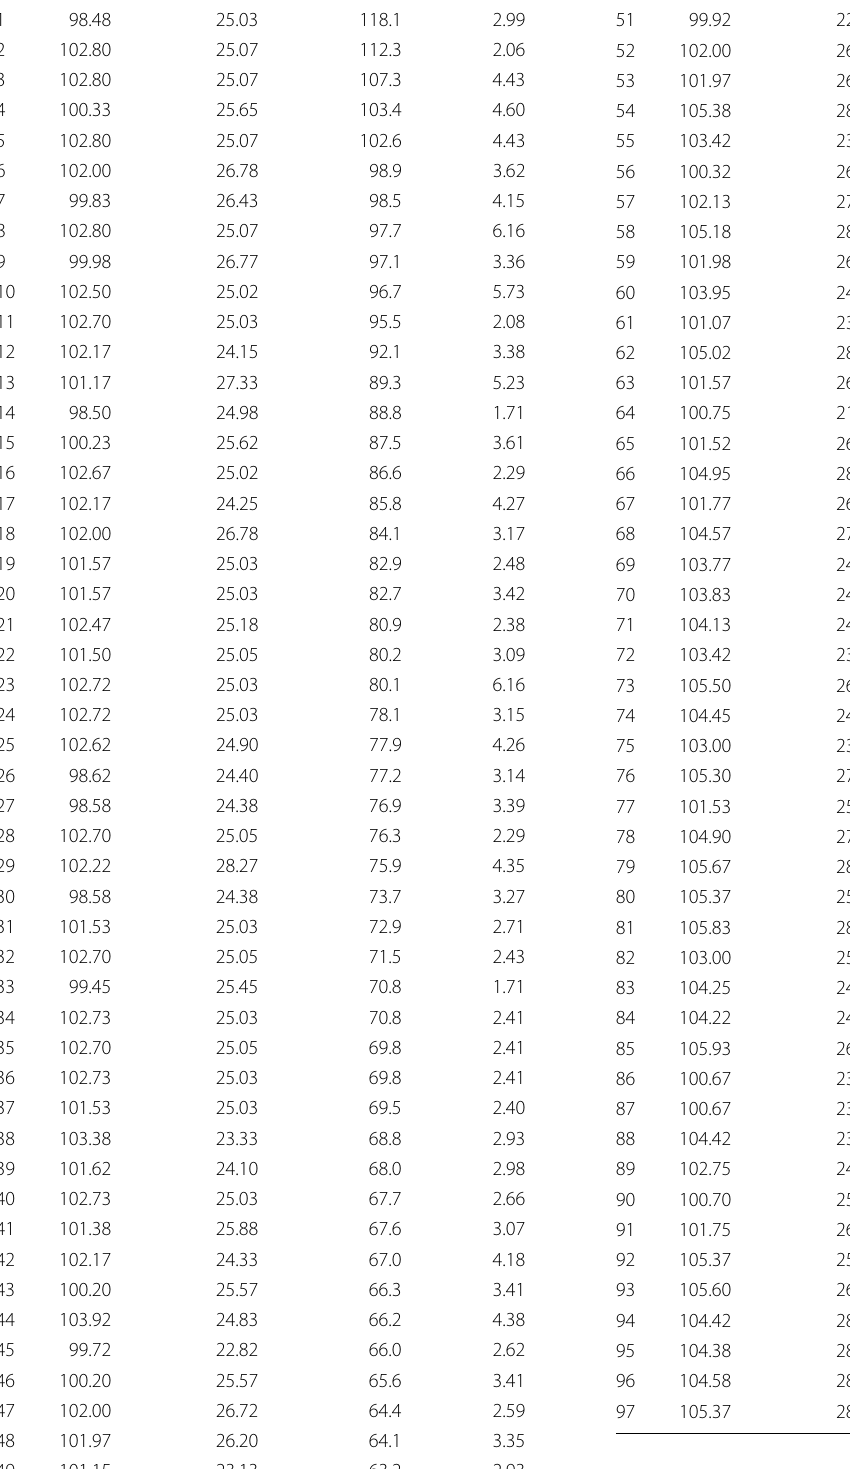
Table 2 Measured data of heat flow (q conductivity ( K